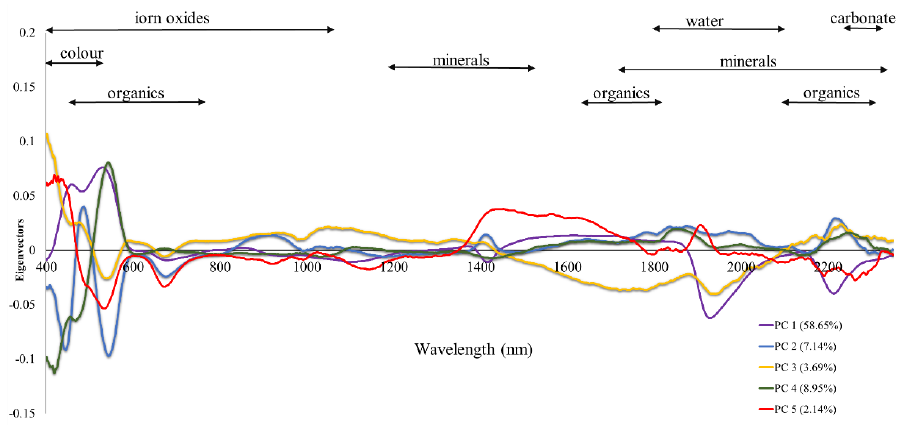
Figure 6. The relationships between the spectral reflectance and principal components (PCs) in different wavelengths.